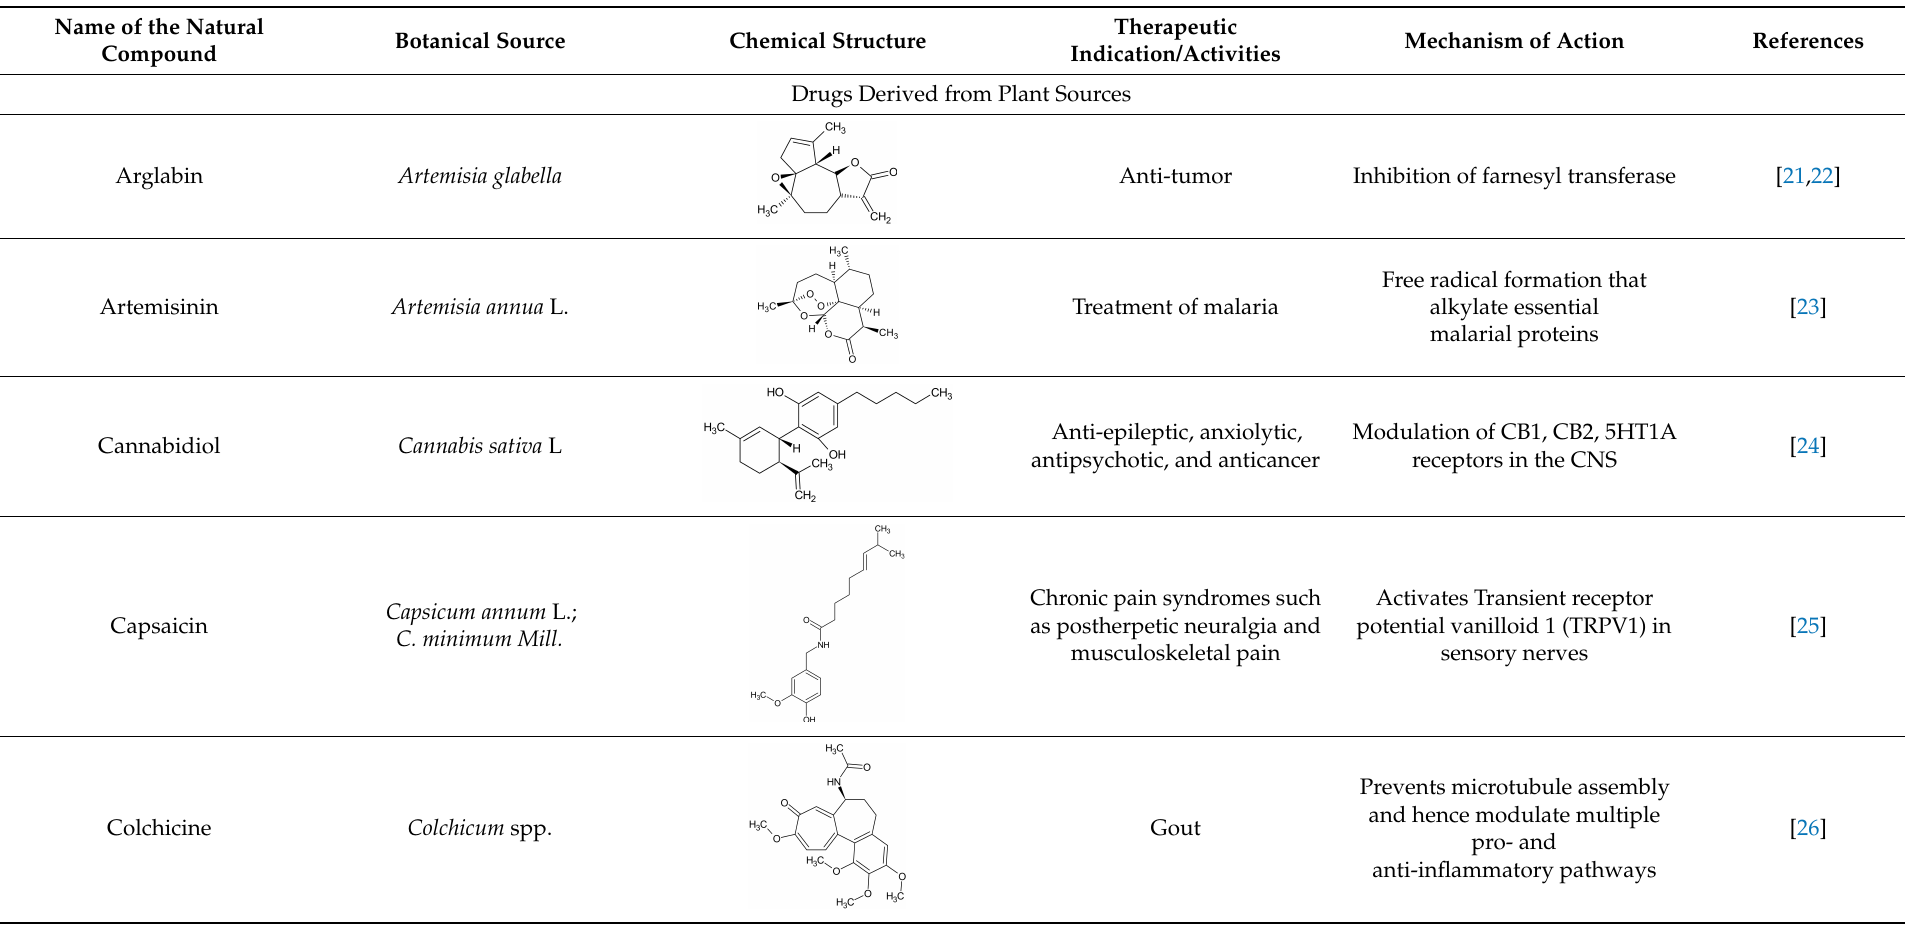
Table 1. Important natural products derived from plant and microbial sources in the last few decades with their therapeutic indications and probable mechanism of